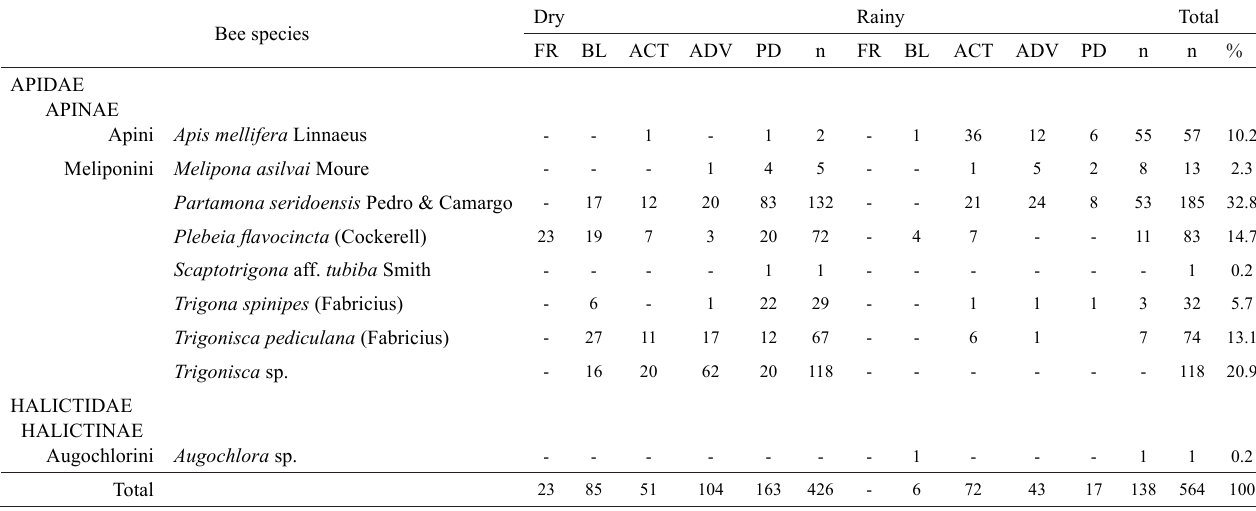
Table 1 . Absolute (n) and relative (%) frequencies of bees on pig carcasses along their decomposition stages in the dry season (Oct/2010) and